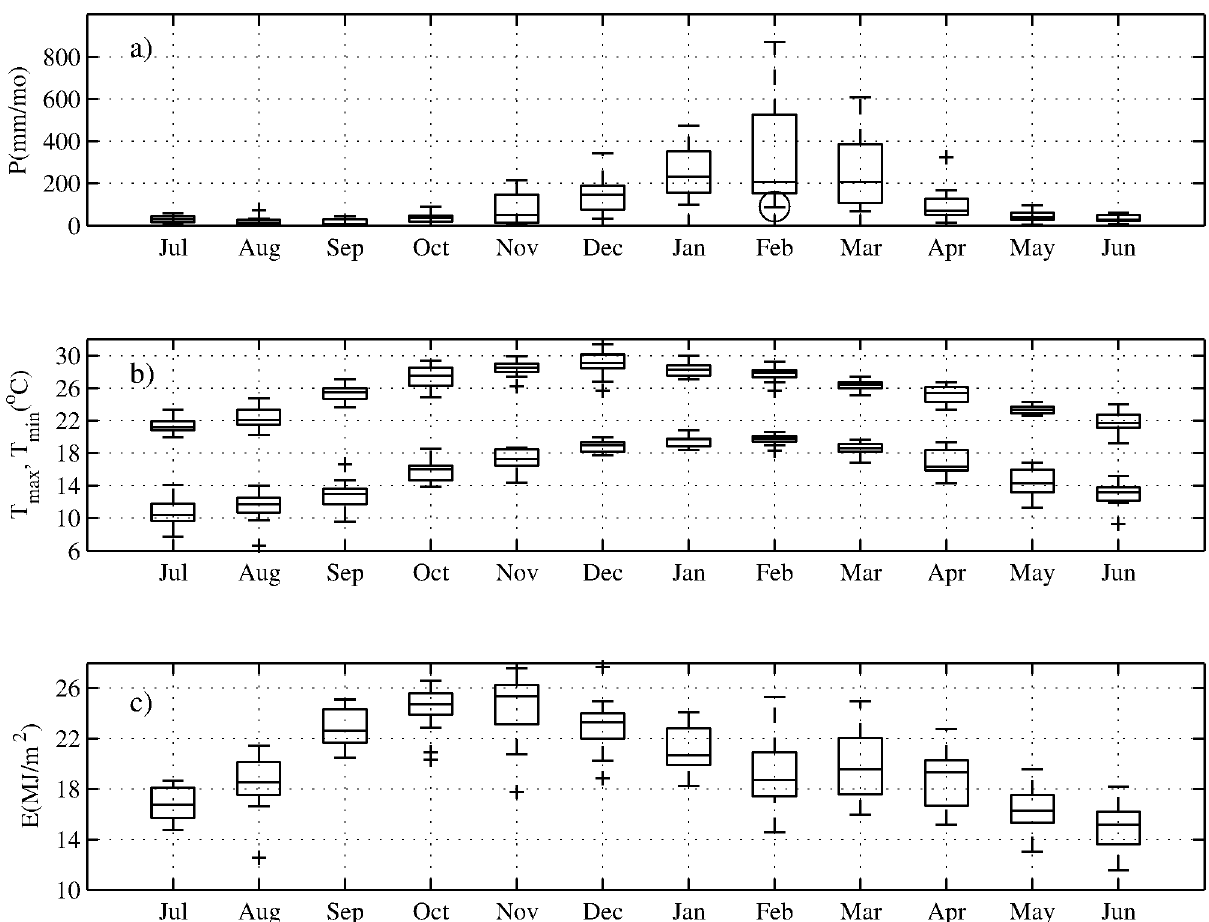
Figure 1. Climatological conditions near the study sites. Monthly averages of precipitation (mm/month; top) daily minimum and maximum temperature ( u C; middle), and daily solar exposure (MJ/m 2 ; bottom) averaged (as available) from Tinaroo Falls Dam (31075) and Kairi Research Station (31034) for 1996–2010 [61]. Boxes indicate 25th and 75th percentile range of data, with the line within indicating the median; whiskers correspond to approximately the 99% range of data assuming a normal distribution; outliers to this range are plotted as small crosses. The exceptionally dry month of February 2005 is indicated by the large open circle.